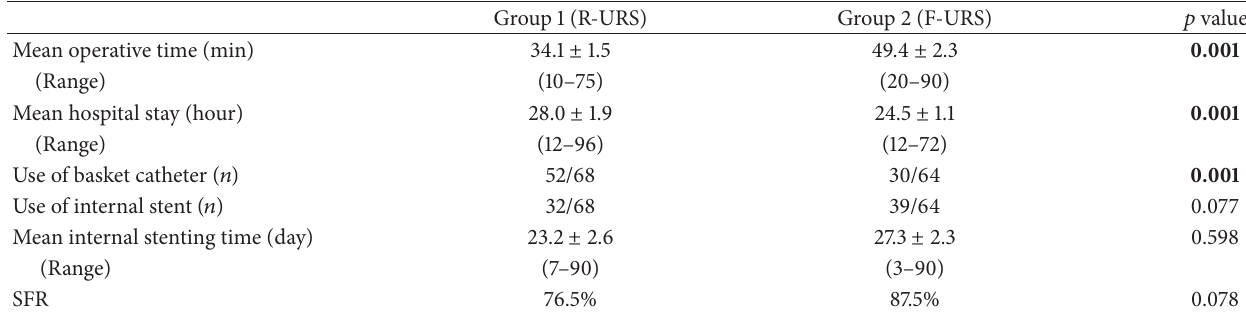
Table 2: Operative and postoperative data.